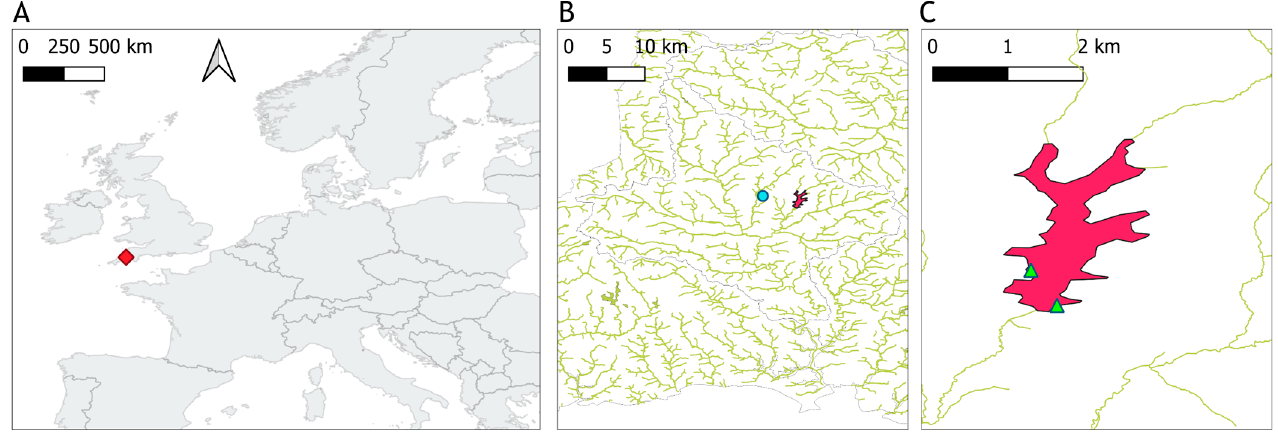
Figure 1. Location of Roadford Lake. ( A ) The location of the reservoir indicated with a red diamond marker. ( B ) The meteorological station “Virginstow, Beaworthy” represented by a turquoise circle to the west of the reservoir in magenta color. ( C ) Green triangles represent the sampling points on the reservoir.